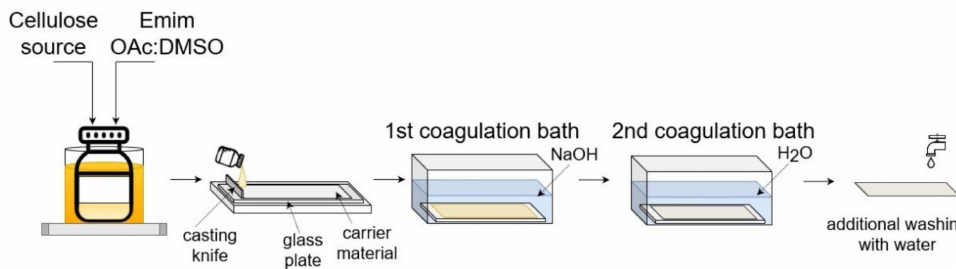
Figure 1. A schematic of the casting procedure.